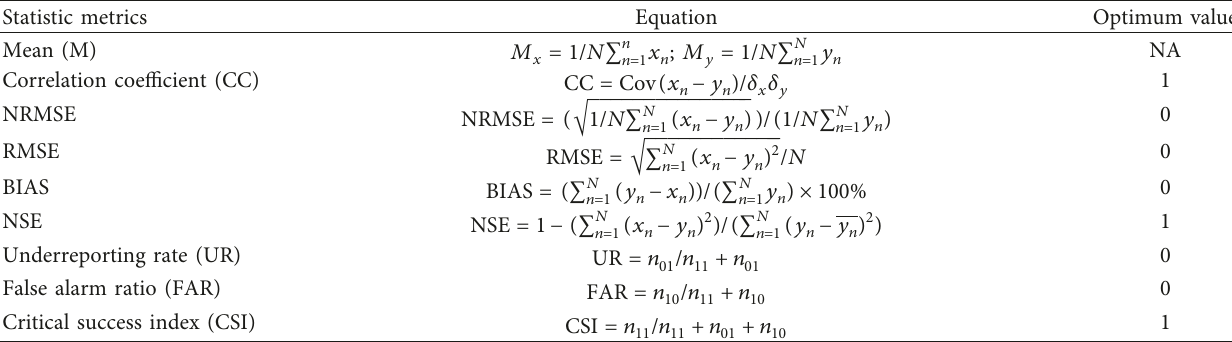
Table 2: List of the statistical metrics used in the evaluation.